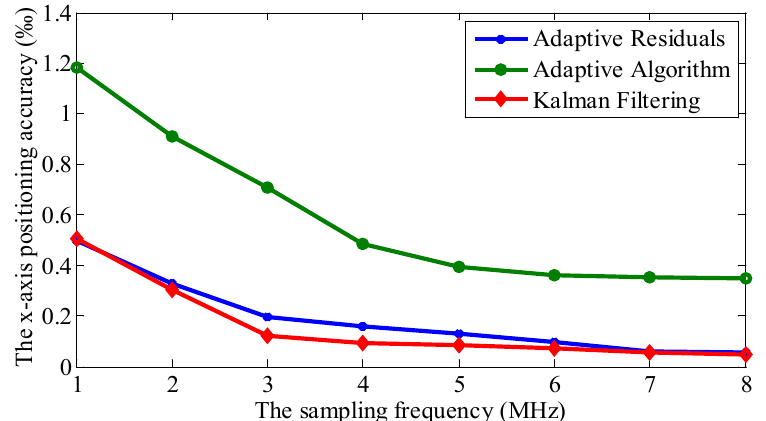
Figure 7. Comparison of the positioning accuracies under different sampling frequencies.